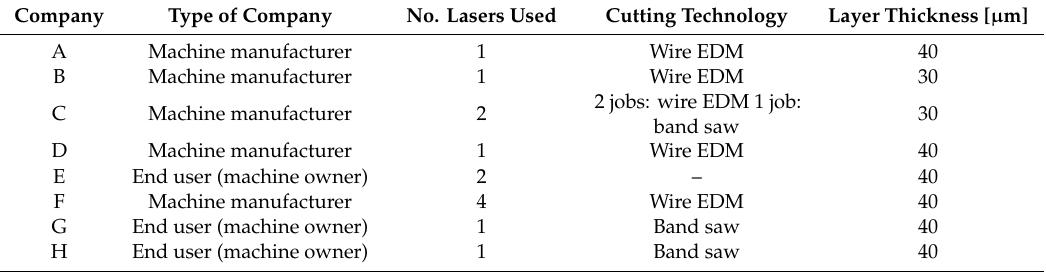
Table 6. Machines evaluated in this benchmarking. Machine H is the only one whose information will be shared: Yb fiber laser, max power 200 W, building platform 250 × 250 mm, nitrogen atmosphere, hard ceramic recoater.